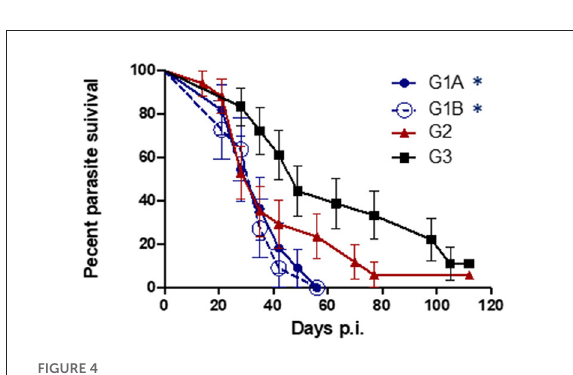
FIGURE4 Kaplan-Meier curves. Survival proportions of the parasite in immunized/challenged groups: Trichobovis via subcutaneous (SC; G1A) or intravulvar (IVU; G1B) routes and TrichGuard vaccine by SC route (G2); and in non-immunized/challenged group (G3) throughout the experiment. All challenged cows were inoculated intravaginally with 2 × 10 6 T. foetus trophozoites. The vertical descent indicates the day p.i. on which an animal cleared the genital infection. Asterisks indicate significant differences in G1A and G1B vs. G3.